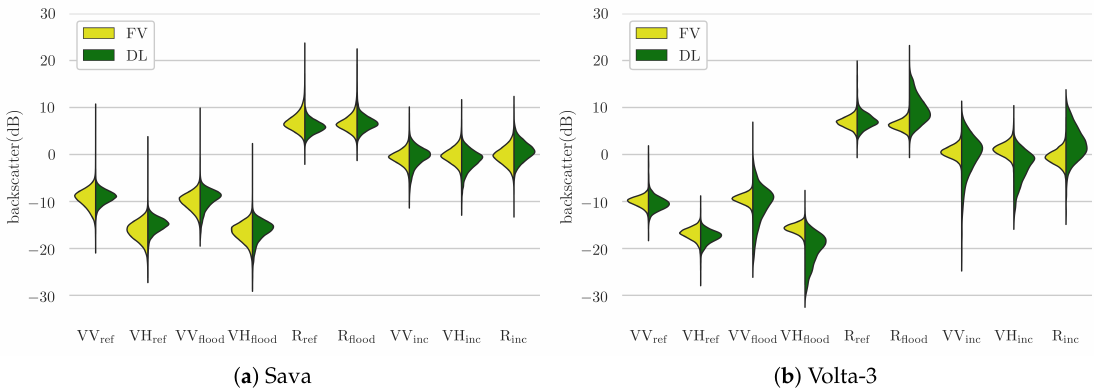
Figure 3. Violin plots demonstrating the class distributions of dry land (DL) and flooded vegetation (FV) objects across the different SAR features for the Sava ROI ( a ) and subset 3 of the Volta ROI ( b